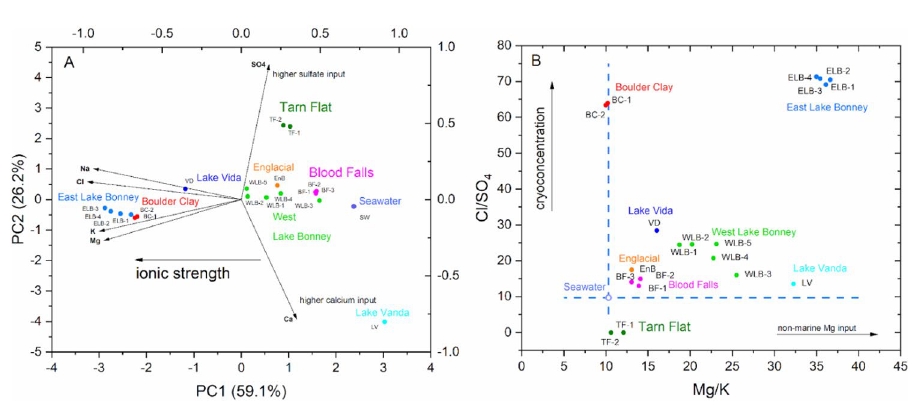
Figure 2. ( A ) Biplot PC1 vs PC2 ( B ) Cl/SO 4 vs